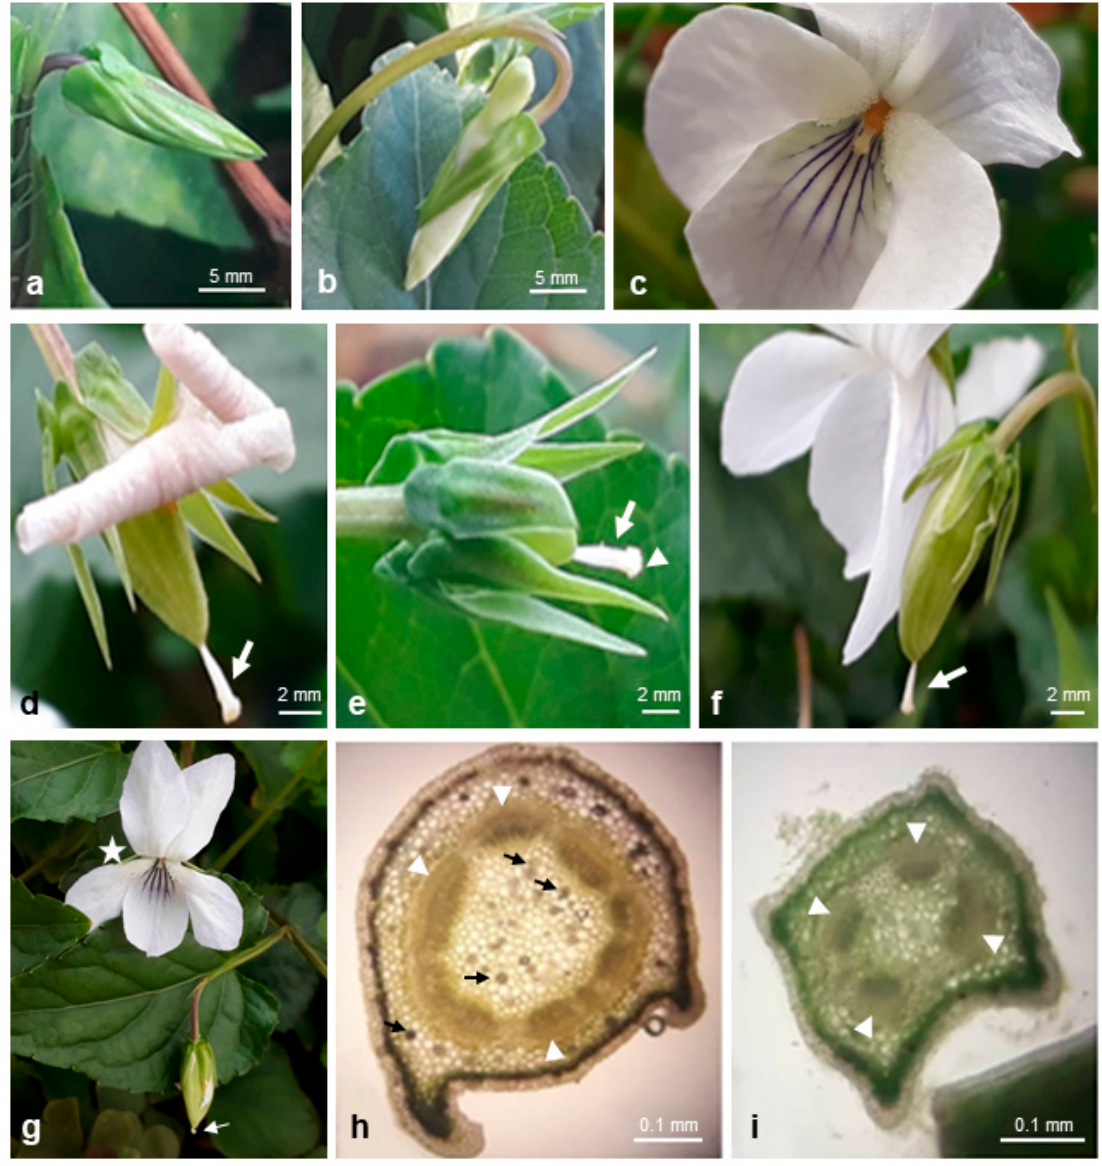
Figure 3. Viola caspia under greenhouse conditions. CH flower developmental stages. ( a , b ) Buds. ( c ) Face view of flower. ( d – f ) Stages of fruit development, enlarged ovary, straight pistil style (arrows) ending with head-like hairy/papillous stigma (arrowhead in e ). ( g ) CH flowers (asterisk) and fruit of CL flowers; note curved style of pistil (arrow). ( h , i ) Cross-section of stem ( h ) and CH peduncle ( i ), vascular bundles (arrowheads), druses in the parenchyma of pith and cortex (arrows).